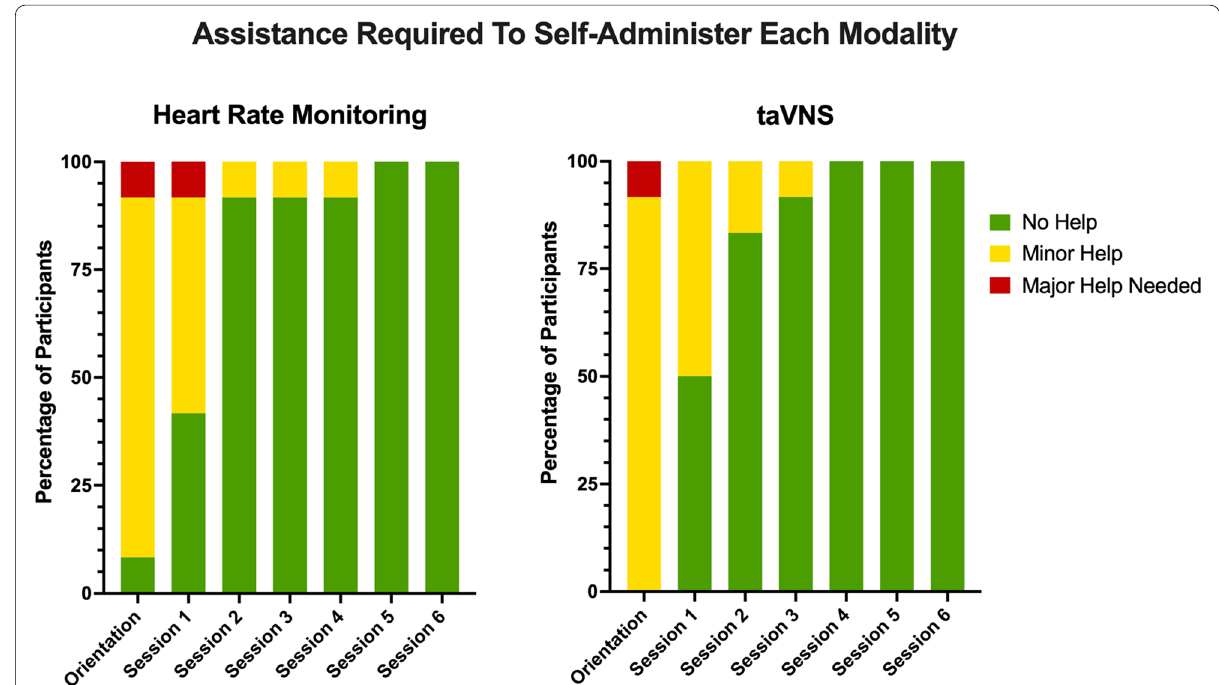
Fig. 3 Remote Monitoring of Self-Administration Feasibility. We virtually monitored whether participants needed assistance with both the physiology monitoring and the self-administration. As demonstrated in the graphs, most participants were able to self-administer physio and taVNS proficiently within 3